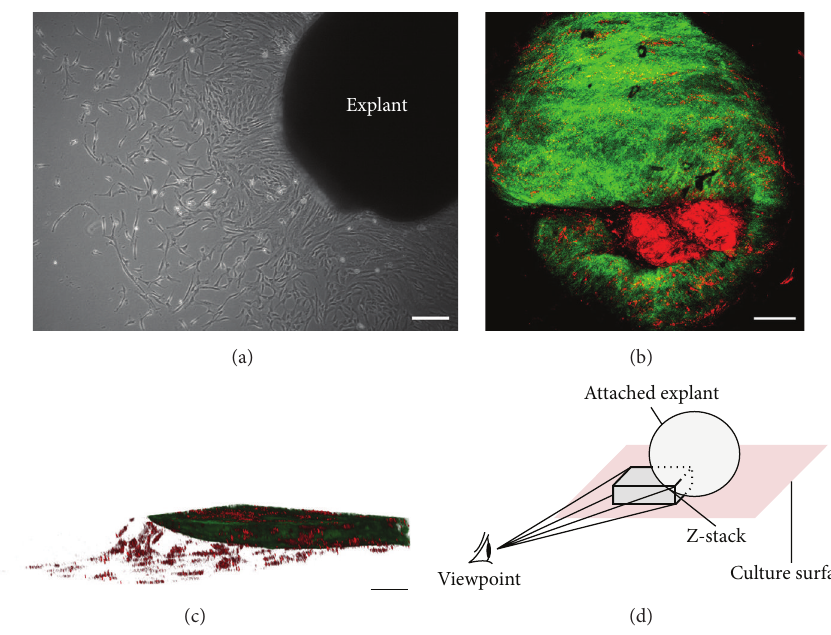
Figure 4: Marker-free visualization of Wharton’s jelly explant tissue and cell outgrowth. (a) Phase contrast image of an attached explant with outgrowing WJ-MSCs, scale bar = 200 𝜇 m. (b) AF (red) and SHG (green) of an attached explant (attachment site, bottom view), scale bar = 100 𝜇 m. (c) 2D image of cellular outgrowth from explant tissue at the attachment site (side view), scale bar = 50 𝜇 m. The images were derived from a Z-stack composition of the SHG and AF signals of (b). (d) Schematic view of the visualization plane of (c). Representative images for 3 independent experiments are